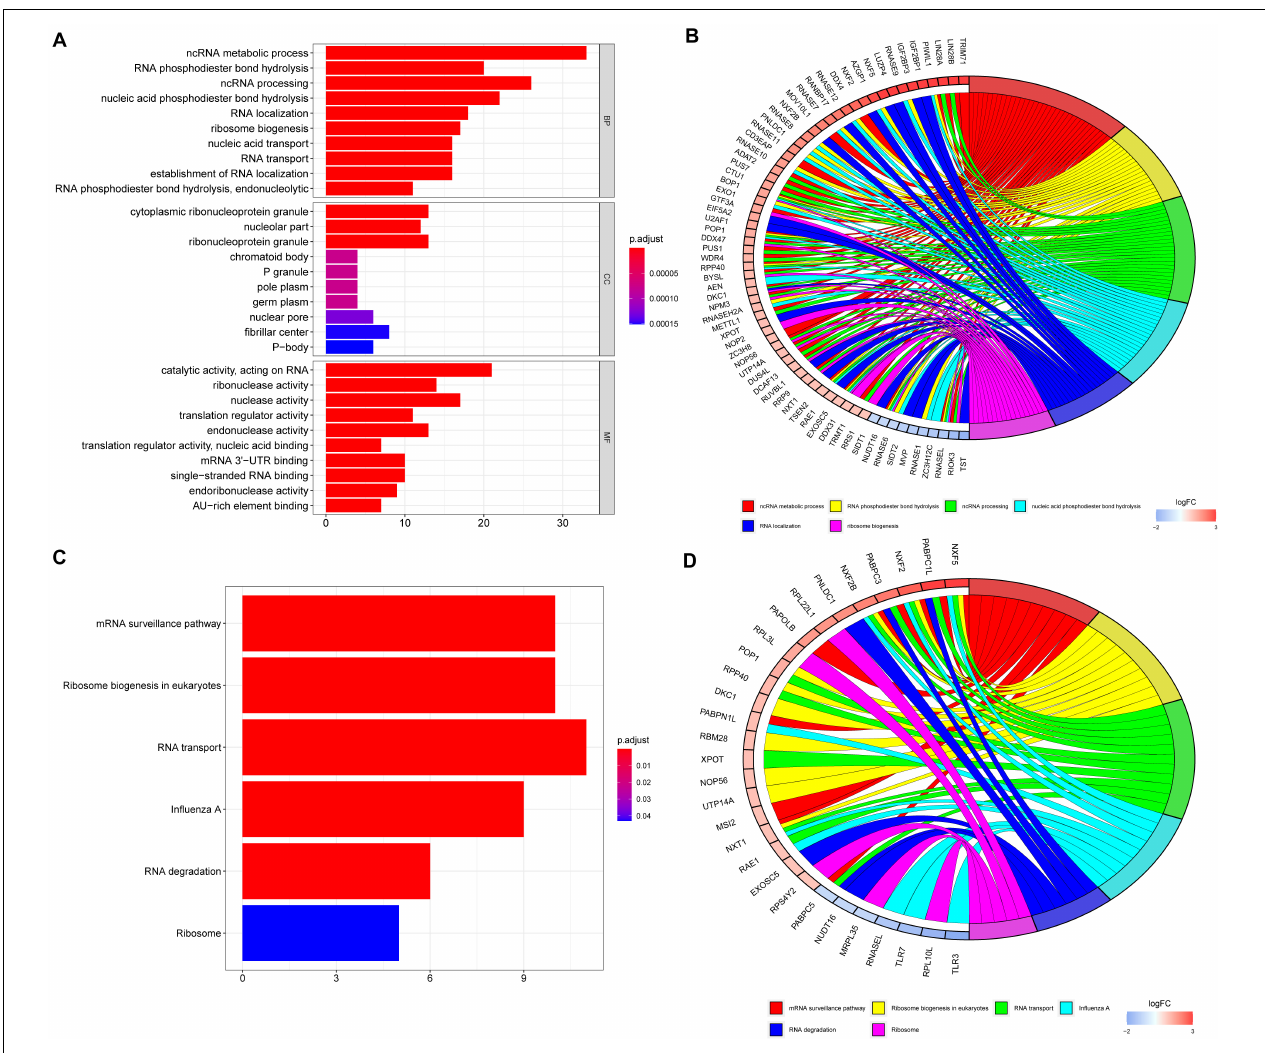
FIGURE 2 | GO and KEGG enrichment analyses of differentially expressed RBPs. (A) GO enrichment analysis including biological processes (BP), cellular compartments (CCs), and molecular functions (MFs). (B) The top six most significant GO enrichment terms. (C) KEGG enrichment analysis. (D) The top six most significant KEGG enrichment